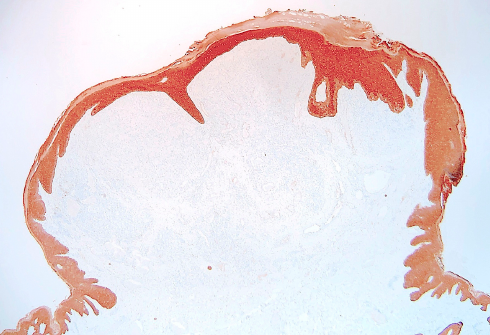
Figure 9. The tumour cells do not express keratin, contrasting with the overlying epidermis (im- munoperoxidase revealed with diaminobenzidine).